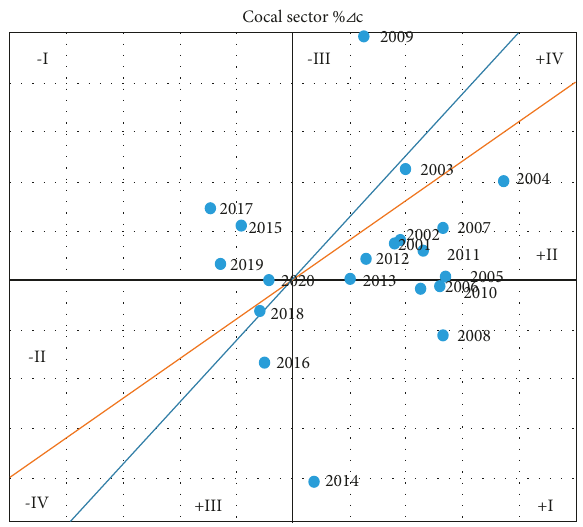
Figure 8: Carbon emission decoupling states of energy consumption in coal sector from 2001 to